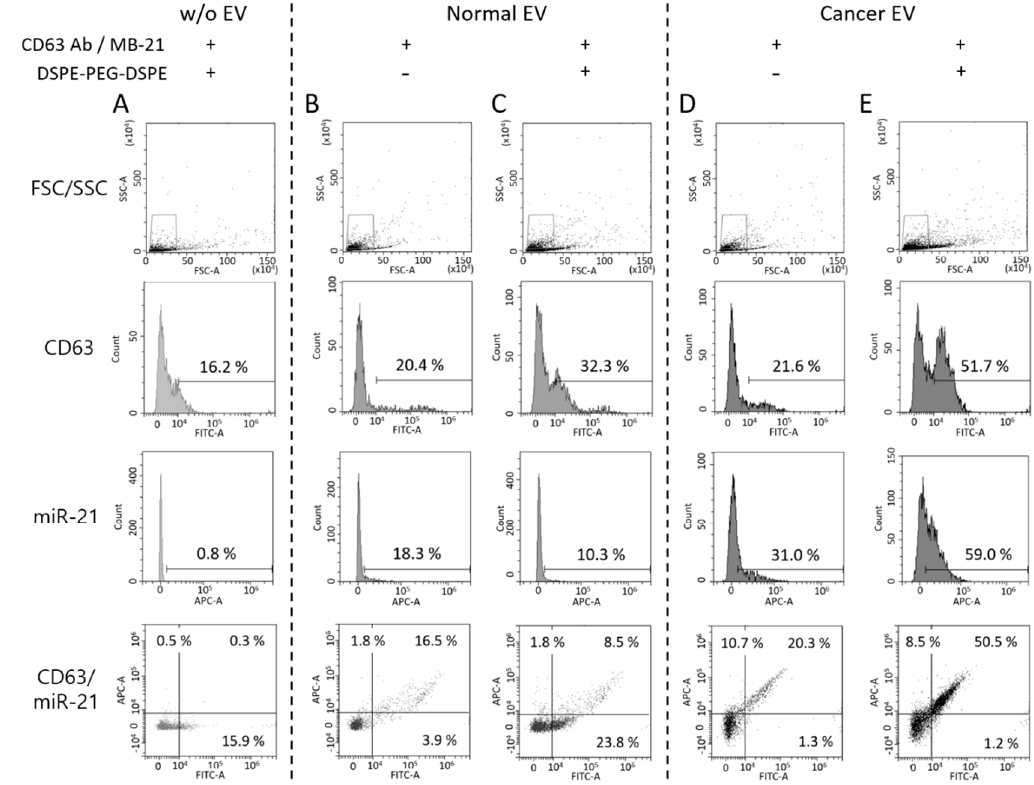
Figure 7. Single step in situ detection of proteins and miRNAs in clustered EVs using a flow cytometer. Forward versus side scatter (FSC/SSC) gatings are shown in the top panel. ( A ) DSPE-PEG-DSPE alone was incubated with CD63 antibody and MB-21 in the absence of EVs ( B , C ) Normal EVs were incubated with CD63 antibody and MB-21 in the absence ( B ) or presence ( C ) of DSPE-PEG-DSPE. The percentages of CD63 and miR-21 positive populations were analyzed using a flow cytometer. The percentages in the quadrant plot of CD63 (x-axis) and miR-21 (y-axis) indicate the number of CD63 and/or miR-21 positive EVs among the total EVs. (D-E) Cancer EVs were analyzed after incubation with CD63 antibody and MB-21 in the absence ( D ) or presence ( E ) of DSPE-PEG-DSPE. The CD63 and miR-21 positive populations were analyzed using a flow cytometer. The quadrant plot of CD63 (x-axis) and miR-21 (y-axis) demonstrates that induction of an EV cluster enhanced the detection efficiency of EV biomarkers using flow cytometry. The overall percentage of CD63 and miR-21 positive EVs increased upon DSPE-PEG-DSPE treatment. Cancer EVs displayed a drastic increase in the populations of both CD63 and miR-21 positive EVs, as compared to normal EVs.